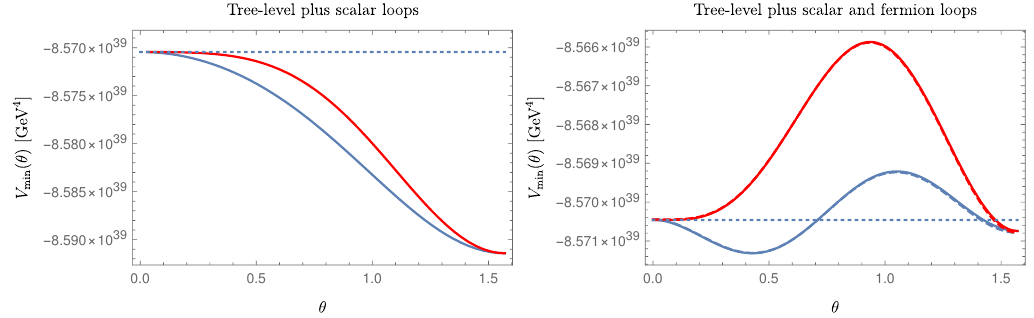
Figure 8 . Scalar potential V min ( (cid:18) ) along the lowest-energy path connecting the minima along the ’ and (cid:8) axes in the two-(cid:12)eld symmetry breaking model of eq. (5.8). We have parameterized the path with (cid:18) (cid:17) arctan (cid:8) =’ . On the left, only scalar corrections are included, while the right plot accounts for both scalar and fermion loops. The blue lines have (cid:21) (cid:8) ’ = 0 : 07000, and the red lines (cid:21) (cid:8) ’ = 0 : 06994; the other parameters are speci(cid:12)ed in the main text. On the right, the solid lines were obtained with a (cid:12)xed renormalization scale, and the dashed lines with a (cid:12)eld-dependent scale set to the maximum of the e(cid:11)ective masses in a given (cid:8) ; ’